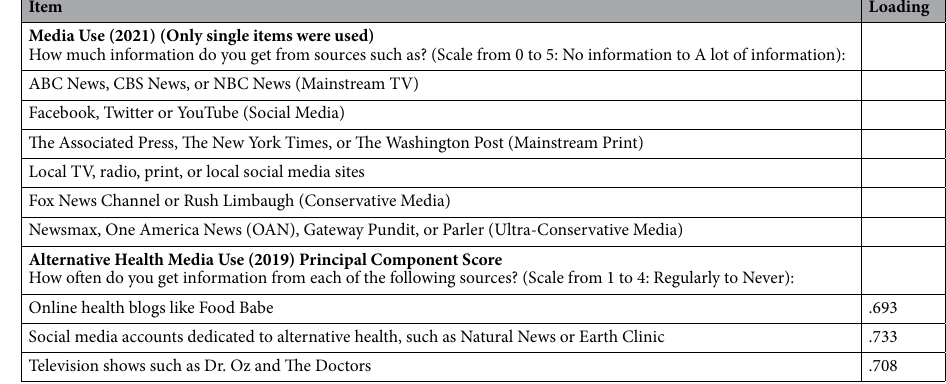
Table 5. Measures of media use at both times.